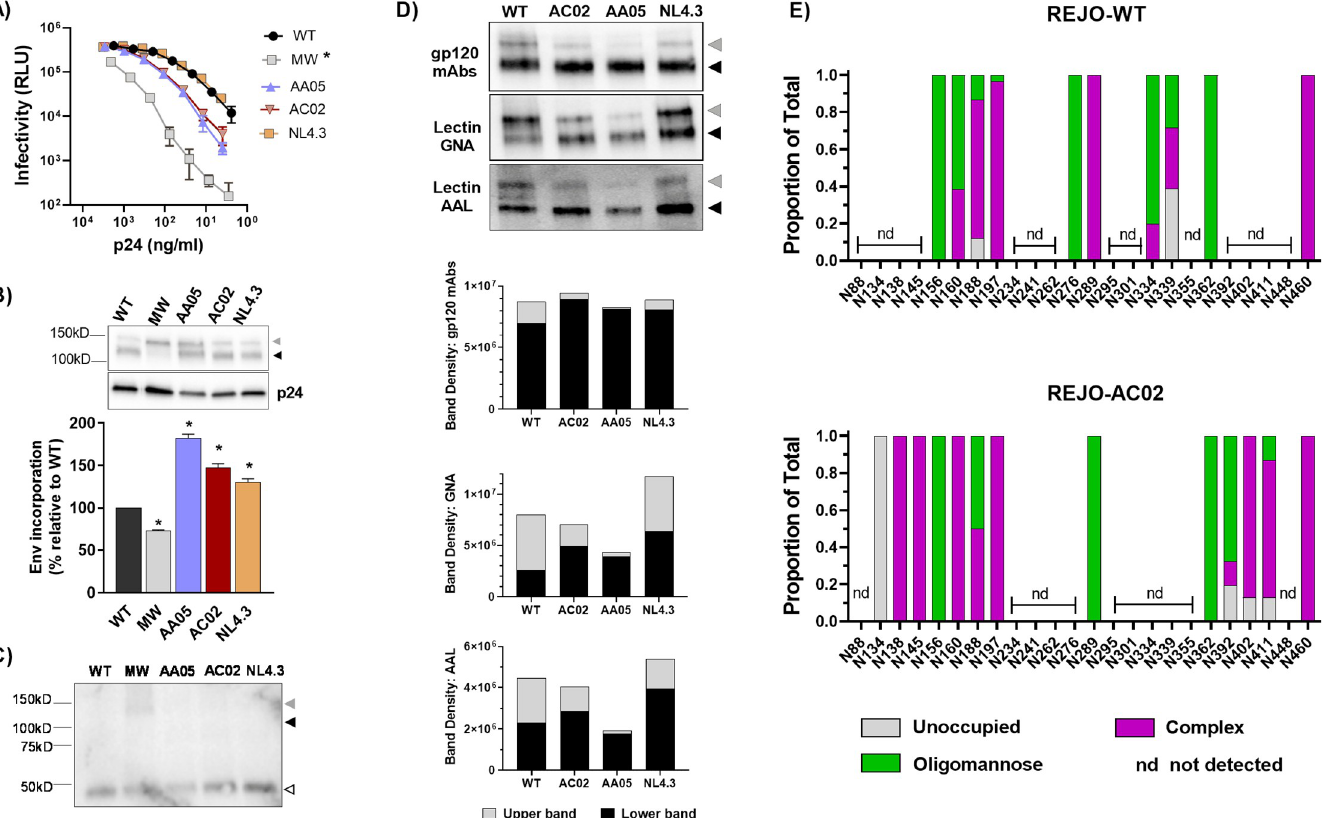
Fig 5. Effects of SP swap on REJO. (A) Infectivity of WT vs SP-swapped REJO derived from 293T cells in TZM.bl cells. � , p = 0.01 vs WT by Mann-Whitney test. (B) Measurement of Env incorporation into virions by Western blot. � , p values range from < 0.0001 to 0.0016 vs WT by one-way ANOVA. (C) Western blot probed with gp41 MPER mAb 2F5. (D) Analysis of REJO Env glycosylation by lectin-probed Western blotting. (E) Relative amounts of unoccupied, oligomannose, and complex glycans at glycosites detected on the WT and AC02 SP-swapped REJO Envs as determined by LC-MS/MS. Gray, black and white triangles denote the positions of upper gp160, lower gp120, and gp41 Env bands, respectively.